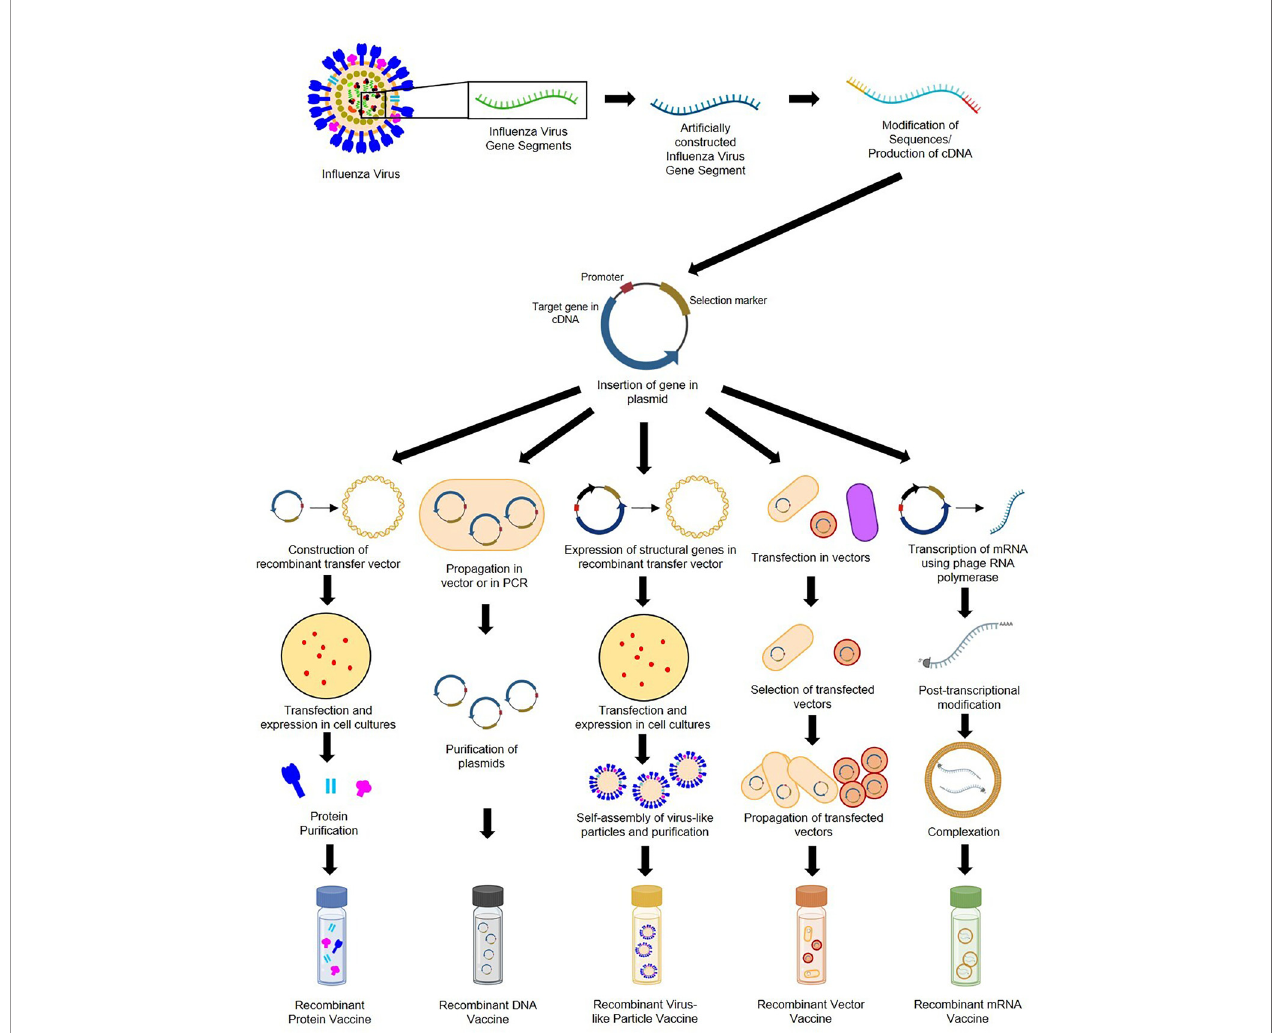
FIGURE 4 | General construction process of recombinant protein, DNA, VLP, vector-based, and mRNA in fl uenza